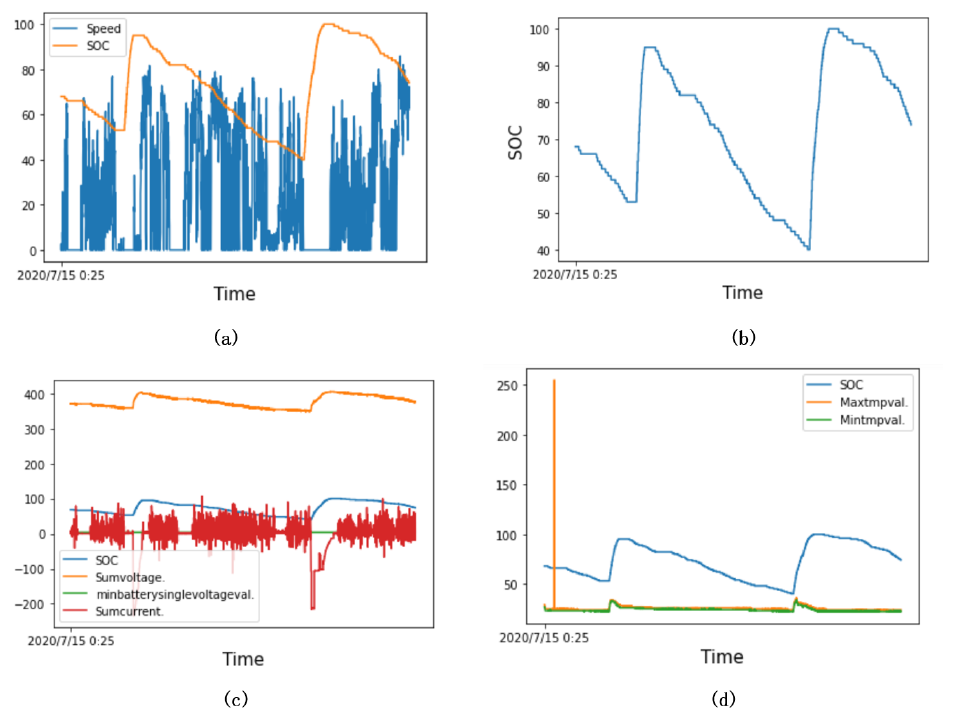
Figure 10. ( a ) SOC and speed; ( b ) SOC and time; ( c ) SOC and sumvoltage, sumcurrent, and minbatterys- inglevoltageval; ( d ) SOC and maximum temperature and minimum temperature.